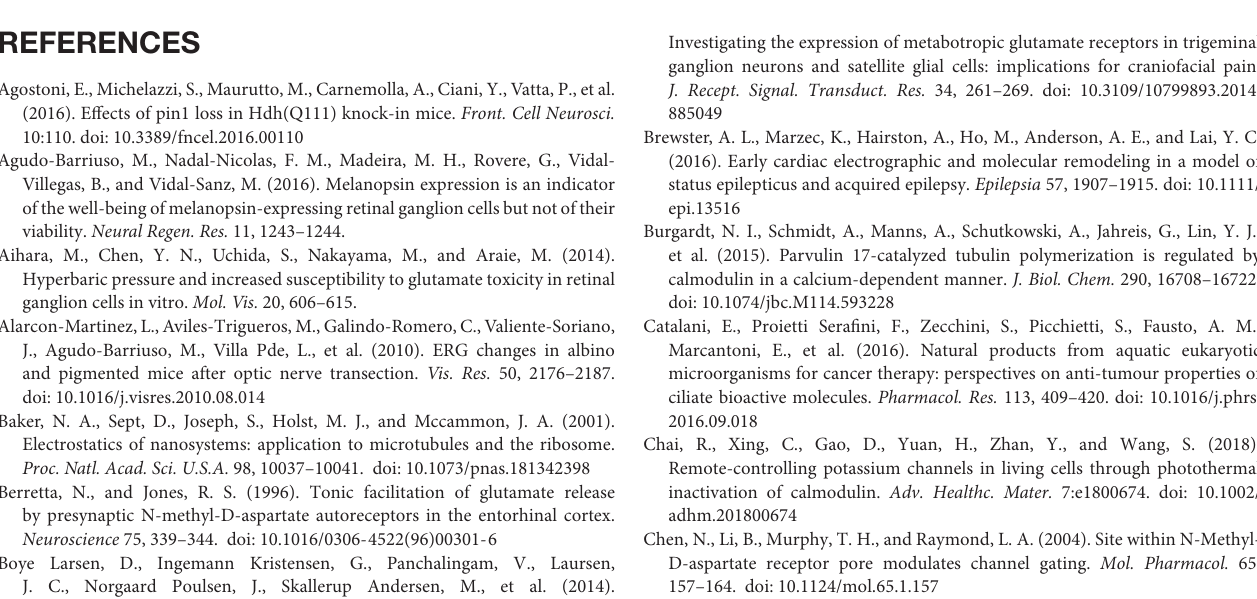
FIGURE S1 | Expression of NR1 and GluR1 after antagonist and glutamate treatment. (A) Western blot assay of NR1 and GluR1 protein expression in glutamate group and iGluRs inhibition group. (B) The statistical analysis of NR1 and GluR1 expression. MK, CN and MC were used at a concentration of 10, 10, and 50 µ M 30 min before 15 min glutamate insult. To ensure consistency of the results, experiments were repeated three times. Data were analyzed using one-way